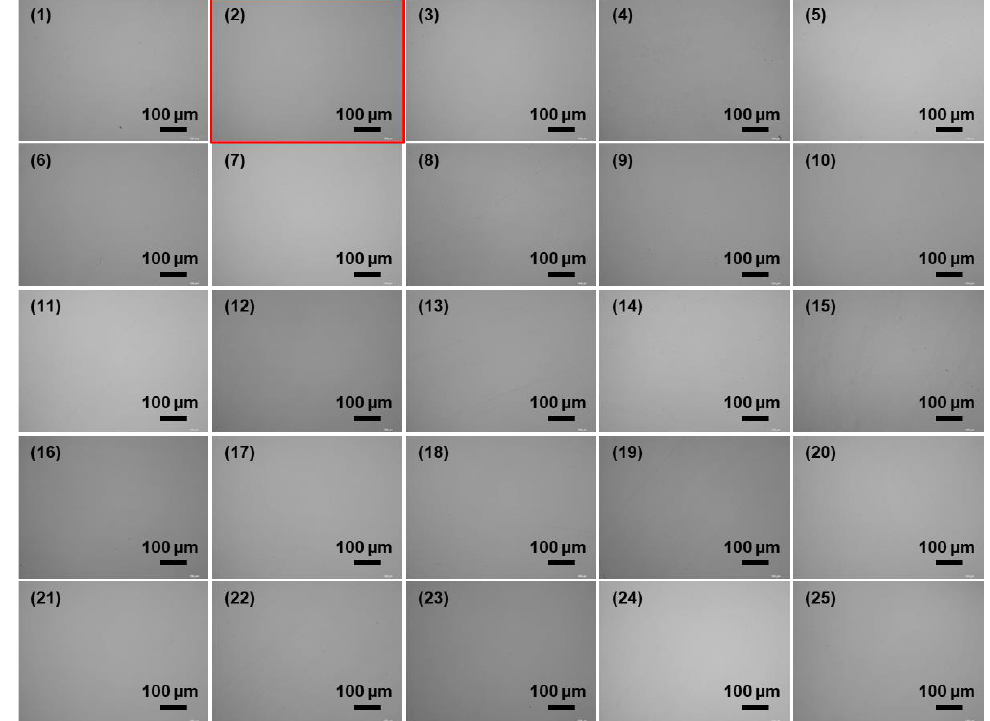
Figure A1. Surface morphology of all samples from the orthogonal experiment.